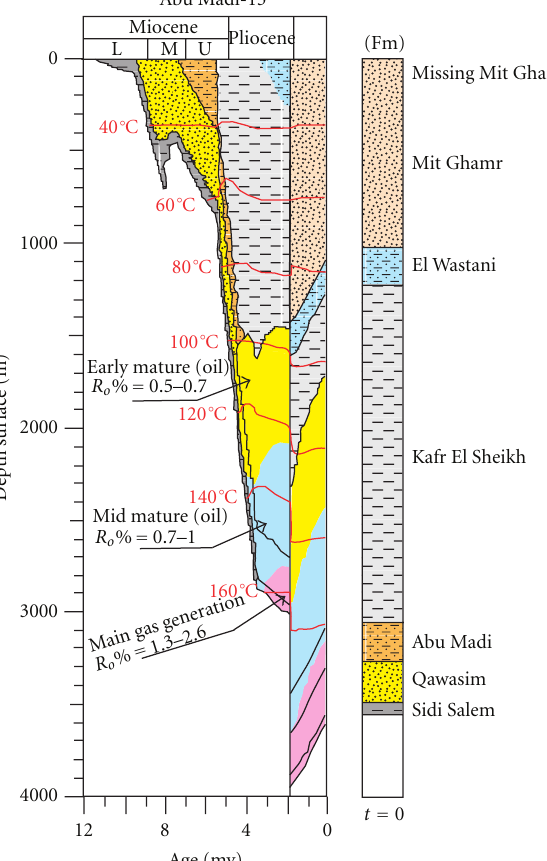
Figure 8: Burial history curve for Abu Madi-15 well showing kinetic window of stratigraphic